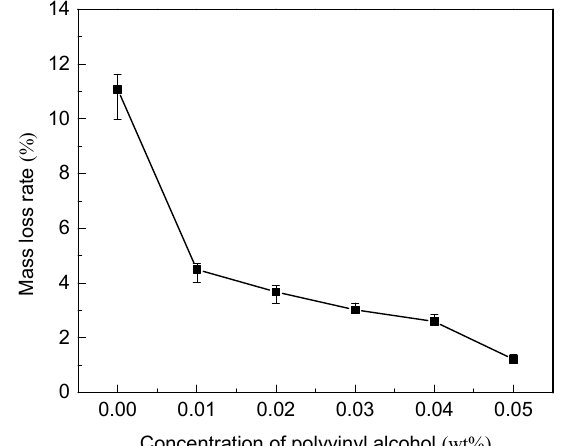
Figure 9. Changes in the mass loss rate of the conductive layer of the MWCNTs/PVDF conductive membrane.